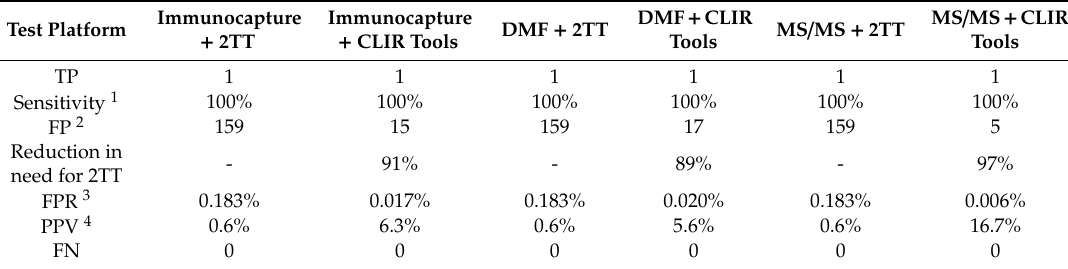
Table 6. Comparison of screening results without and with CLIR for mucopolysaccharidosis type I using di ff erent assay platforms and 2nd tier testing. The basis for this comparison is the population used for CLIR analysis ( n = 87,321) and shows that the application of CLIR reduces the need for 2nd tier tests and improves the screening performance.